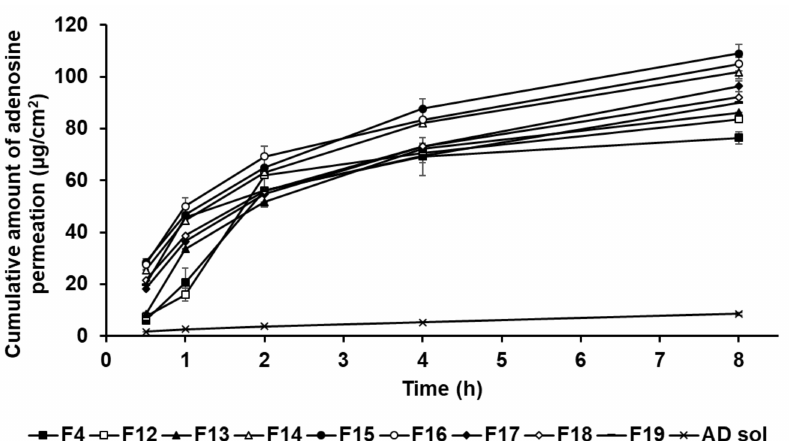
Figure 12. Cumulative permeation profiles for adenosine from solid lipid nanoparticles into the medium. Results are expressed as the means ± standard deviations of three independent experiments ( n =